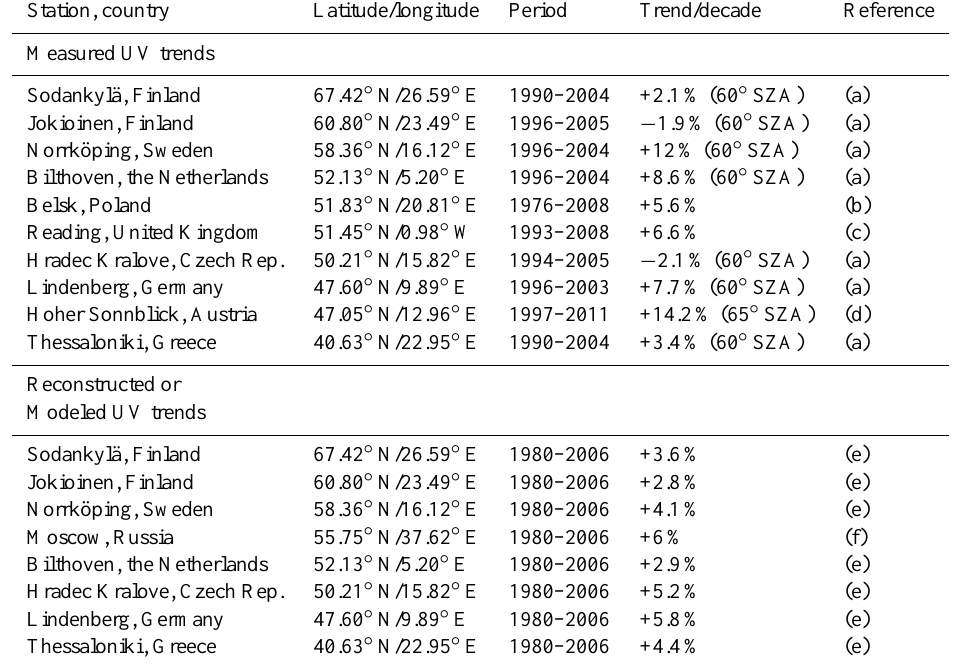
Table 6. Trends of UV radiation at different stations from (a) Bais et al. (2007), (b) Krzýscin et al. (2011), (c) Smedley et al. (2012), (d) Fitzka et al. (2012), (e) den Outer et al. (2010) and (f) Chubarova